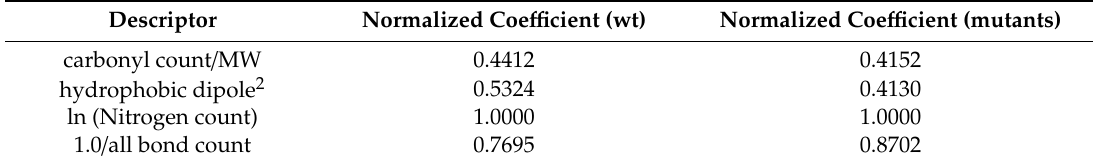
Table 2. Relative weights of the descriptors for wild type and mutated HIV-reverse transcriptase (-RT).